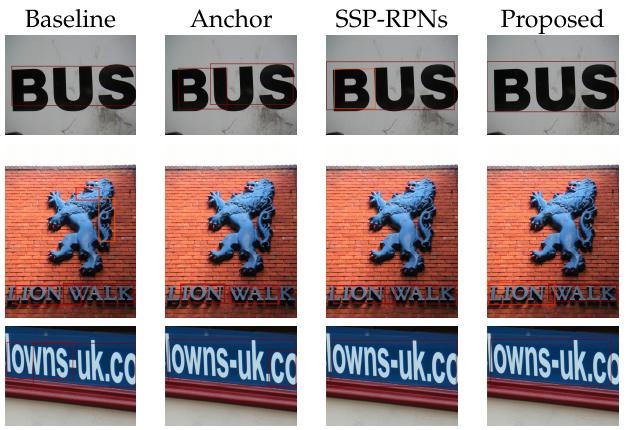
Figure 6. Detection examples in ablation